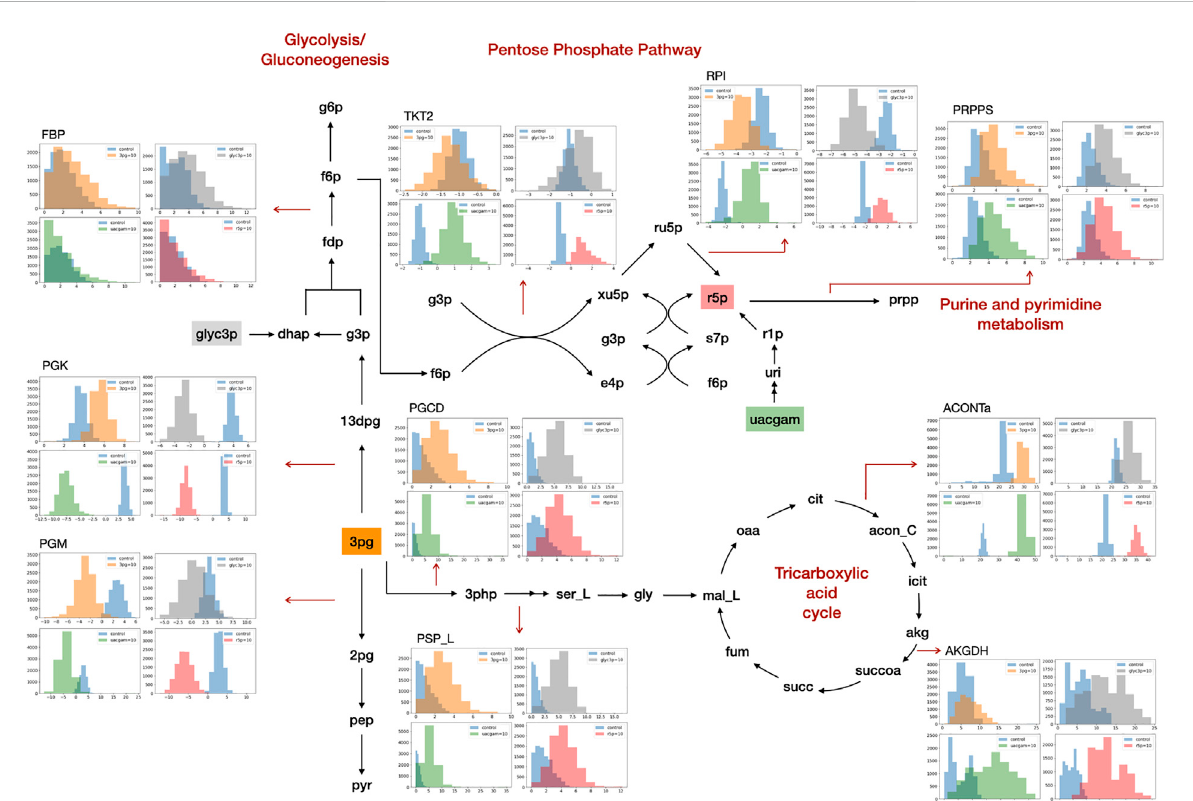
FIGURE 1 Metabolite feeding of 3PG, GLYC3P, R5P, and UACGAM induced metabolic alterations. The subgraphs indicate the distribution of sampled metabolic fl uxes(mmol · gDW − 1 · h − 1 )iniKpne_ATCC700603_21(blue,control;orange,3PG;gray,GLYC3P;red,R5P;green,UACGAM).Themetabolite abbreviations are as follows: g6p, D-glucose 6-phosphate; f6p, D-fructose 6-phosphte; fdp, D-fructose 1,6-biphosphate; dhap, dihydroxyacetone phosphate; g3p, glyceraldehyde 3-phosphate; 13dpg, 3-phospho-D-glyceroyl phosphate; 3pg, 3-phosphoglycerate; 2pg, D-glycerate 2- phosphate; pep, phosphoenolpyruvate; pyr, pyruvate; ru5p, D-ribulose 5-phosphate; xu5p, D-xylulose 5-phosphate; r5p, D-ribose 5-phosphate; s7p, sedoheptulose 7-phosphate; e4p, D-erythrose 4-phosphate; prpp, 5- phospho-alpha-D-ribose 1-diphosphate; 3php, 3- phosphohydroxypyruvate; ser_L, L-serine; gly, glycine; mal_L, L-malate; oaa, oxaloacetate;cit, citrate; acon_C, cis-aconitate; icit, isocitrate; akg, 2- oxoglutarate; succoa, succinyl-CoA; succ, succinate; fum, fumarate. The reaction abbreviations are as follows: FBP, fructose-bisphosphatase; PGK, phosphoglycerate kinase; PGM, phosphoglycerate mutase; TKT2, transketolase 2; RPI, ribose-5-phosphate isomerase; PRPPS, phosphoribosylpyrophosphate synthetase; PGCD, phosphoglycerate dehydrogenase; PSP_L, phosphoserine phosphatase; ACONTa,